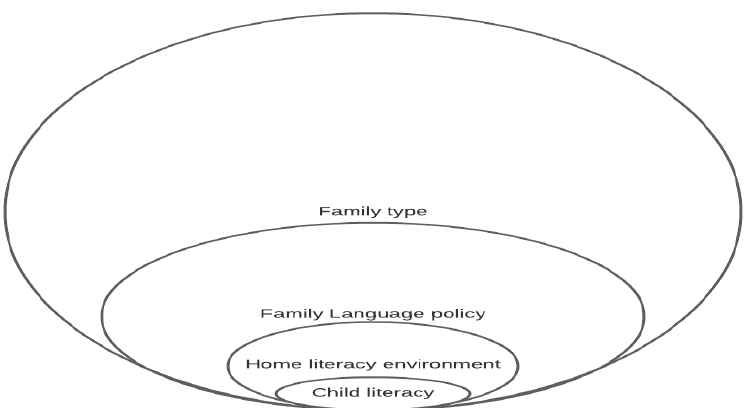
Figure 2. Factors that affect the development of child literacy in Russian families in Cyprus. Table 2. Family type: language use and literacy skills. Mixed